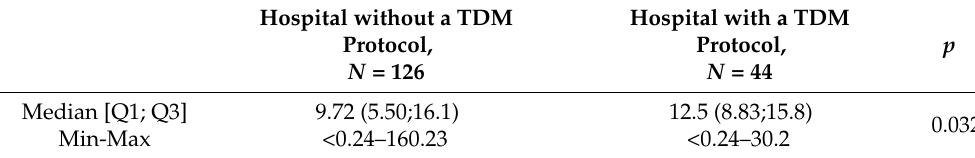
Table 6. Values of vancomycin concentration after the first performed TDM in both hospitals.